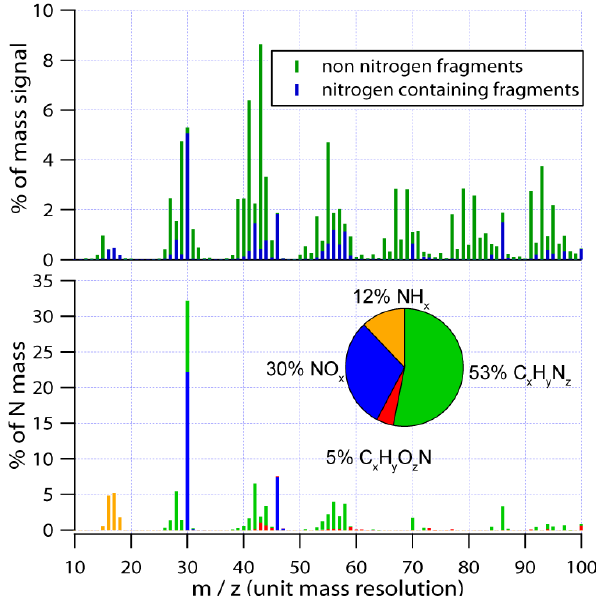
Fig. 2. Top: the average of the AMS spectra of the four standards, with nitrogen and non-nitrogen fragments identified. Numbers identify the m/z of some of the major peaks. Bottom: the average for the standards of the nitrogen containing peaks, weighted by the fraction of each peak which is nitrogen by mass. Each peak . containing one nitrogen atom is scaled by 14 m/z